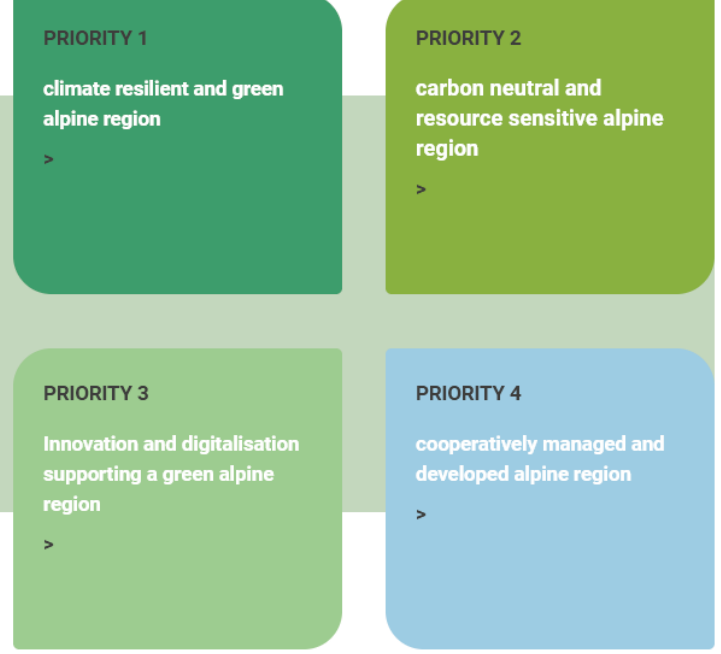
Figure 5. List of priorities of the Alpine Space Programme-Interreg. Source: https://www.alpine-space.eu/, 2022 (accessed on 22 December 2022).